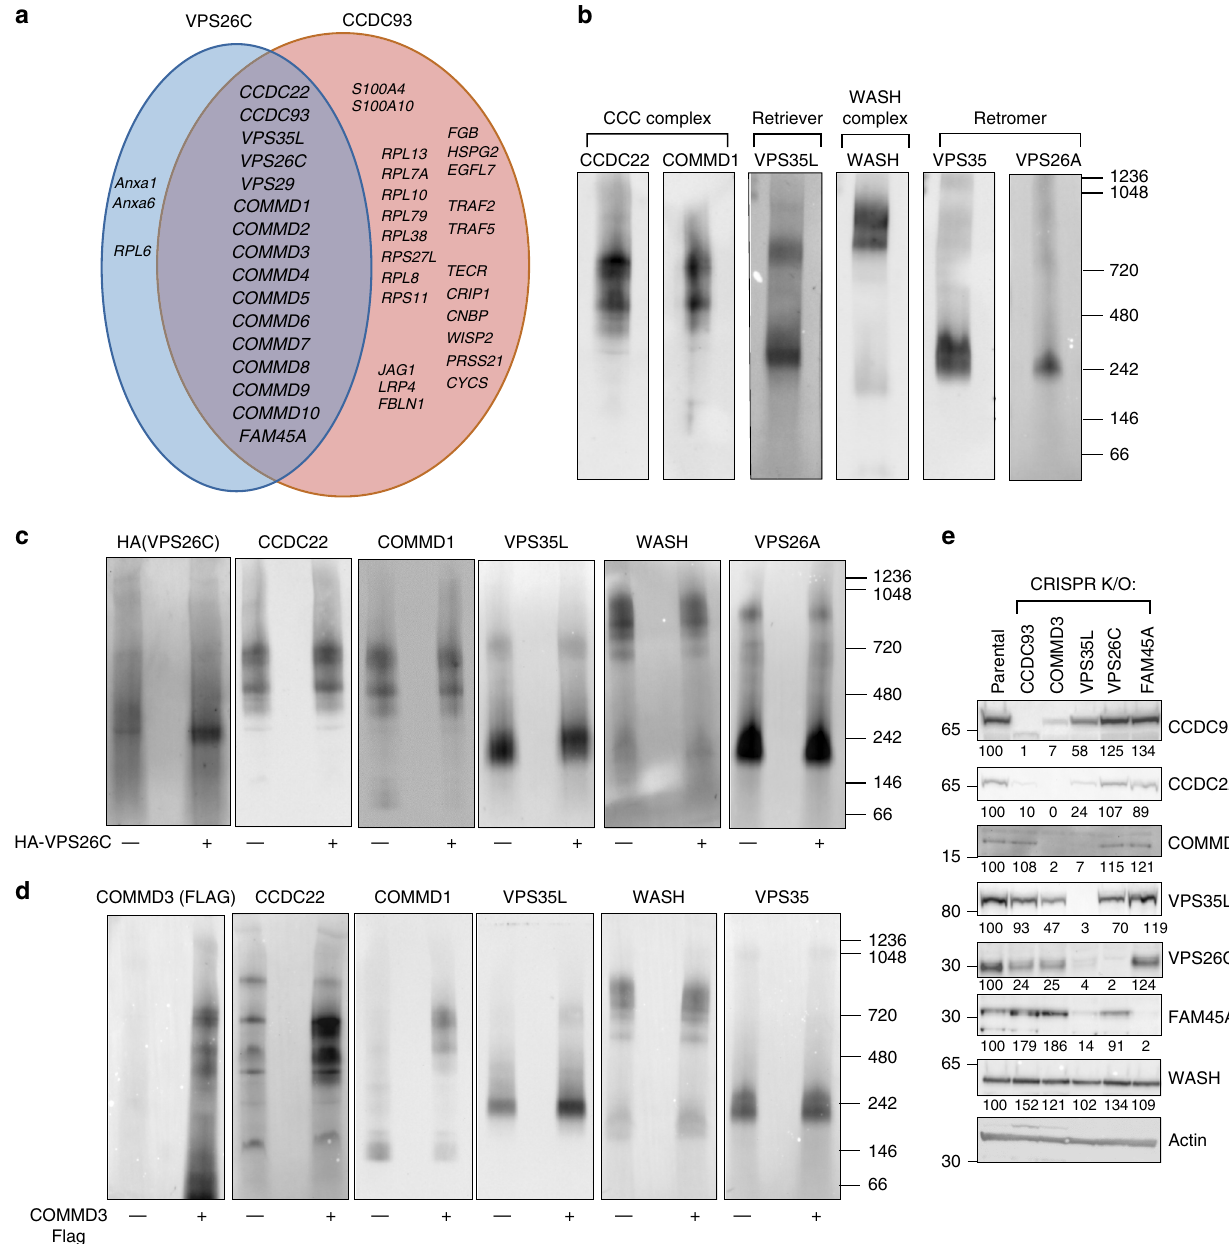
Fig. 1 CCC and retriever are closely associated but distinct complexes. a Venn diagram depicting proteins identi fi ed by LC/MS-MS as interacting partners of VPS26C or CCDC93 in HeLa cells. All proteins presented were within 10-fold in abundance compared with the bait proteins. CRIPSR/Cas9 was used to make KO lines, which were then stably transduced with an empty vector (EV) or HA-tagged versions of VPS26C or CCDC93. b – d Cell lysates from parental HeLa cells b , VPS26C deleted or rescued cells c , and COMMD3 deleted or rescued cells d were resolved using coomassie blue native (BN) gel electrophoresis. This was followed by membrane transfer and immunoblotting using the indicated antibodies. e Expression of CCC and retriever complex subunits was examined by immunoblotting in the indicated HeLa CRISPR/Cas9 knockout cell lines; quanti fi cation after normalization by the loading control (Actin), is also presented as % compared with the parental control (representative of at least three separate